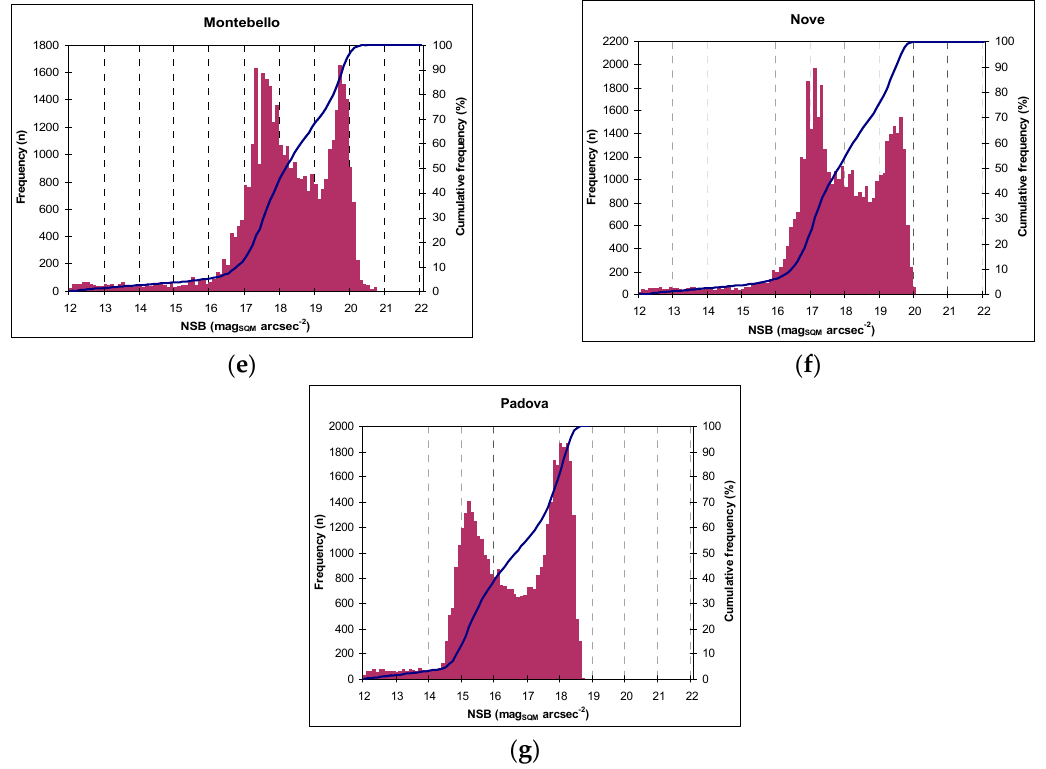
Figure 1. Histograms of absolute frequencies of NSB recorded during 2018 in the following locations: ( a ) Passo Valles, ( b ) Cima Ekar, ( c ) MonteBaldo, ( d ) Pennar, ( e ) Montebello, ( f ) Nove, ( g ) Padova.